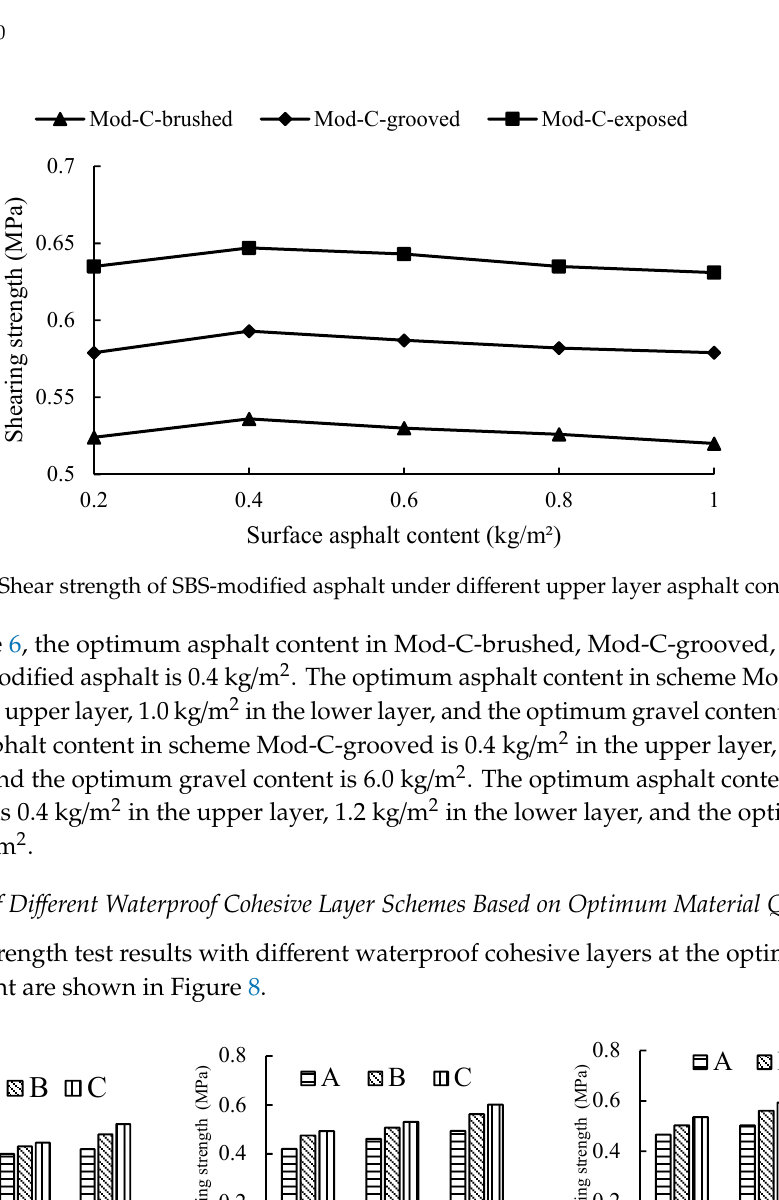
Figure 8. Maximum shear strength of different cement slab surfaces and spreading schemes: ( a ) SBS- modified emulsified asphalt; ( b ) 90 ordinary hot asphalt; ( c ) SBS-modified asphalt.